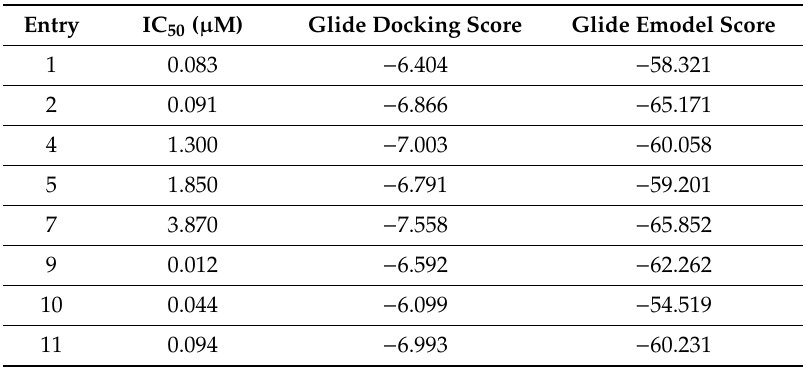
Figure 1. Docking results with the optimized 1ELV structure. Best docking pose ( a ) and ligand interaction diagram ( b ) for compound FUT-175; and best docking pose ( c ) and ligand interaction diagram ( d ) for Subasinghe’s compound 49. Both inhibitors’ amidine group formed a salt bridge with Asp611 and a further H-bond with Ser612. In case of FUT-175 a second salt bridge was formed between the guanidine group and Glu463 and an additional H-bond with the catalytic Ser617 was also observed. Compound 49 was stabilized through its pyrazole ring forming both a π-π stacking interaction with Phe511 and a π-cation interaction with Lys 614. Table 7. Biological data, docking scores and emodel scores of the non-amidine C1s inhibitors obtained by the 2D similarity